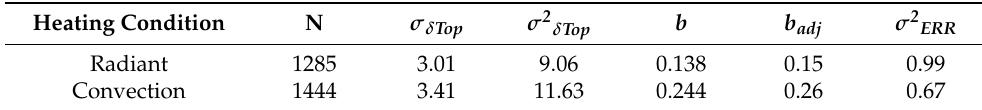
Table 8. Regression coefficients from the